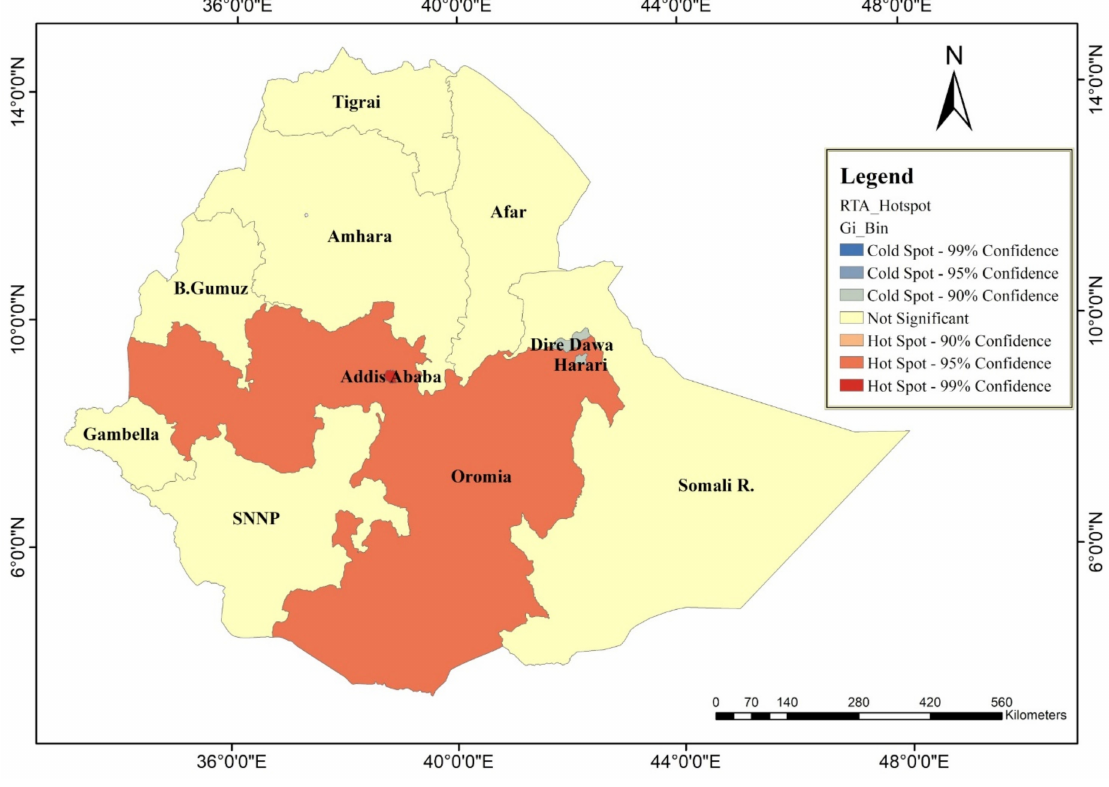
Figure 4. RTC Hot spot map of Ethiopia regions and federal